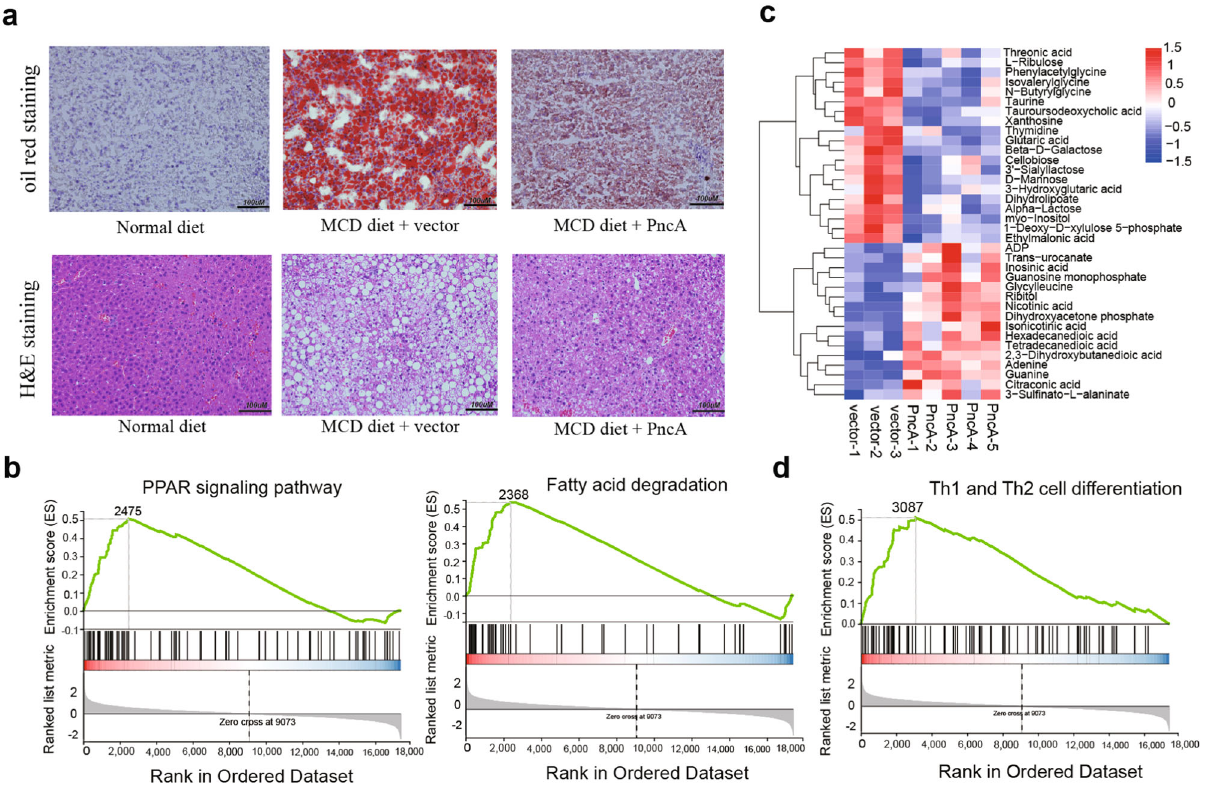
Fig. 6 Improvement in mouse liver lesions by PncA overexpression via AAV. a Representative Oil Red O staining (top) and H&E staining (bottom) of mouse liver sections. b Gene set enrichment analysis (GSEA) of RNA-seq results. c Heatmaps of metabolites with signi fi cant differences between the PncA and vector groups. d GSEA of RNA-seq results. Scale bars 100 µ